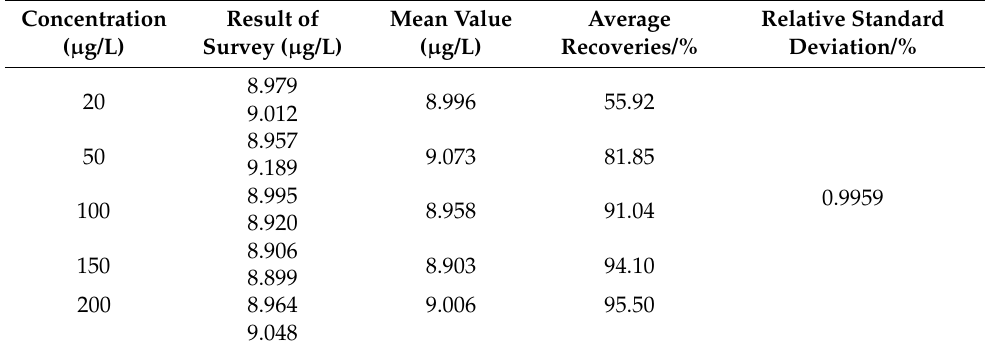
Table 2. Experimental records of precision and recovery of melamine spiked